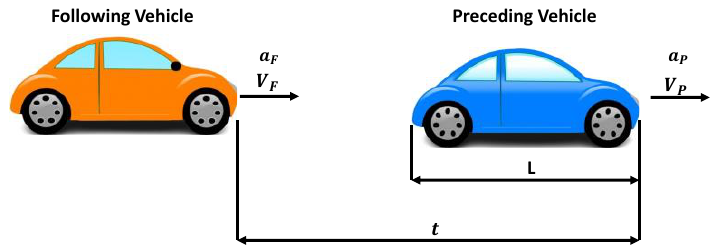
Figure 3. Overview of stopping distance algorithm [19].